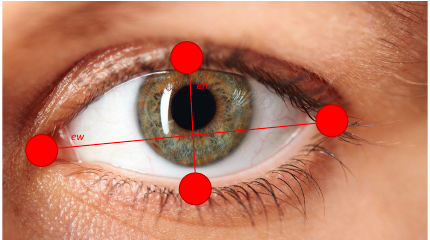
Figure 2. Eye aspect ratio. The aspect ratio ar = eh the open or closed state.